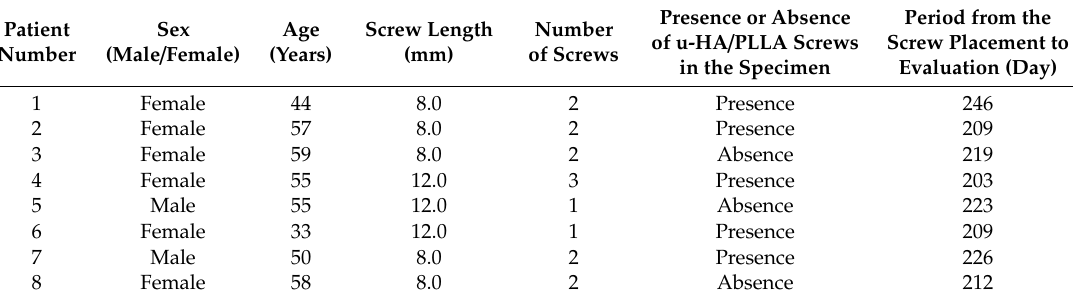
Table 1. Details of patients and u-HA / PLLA screws